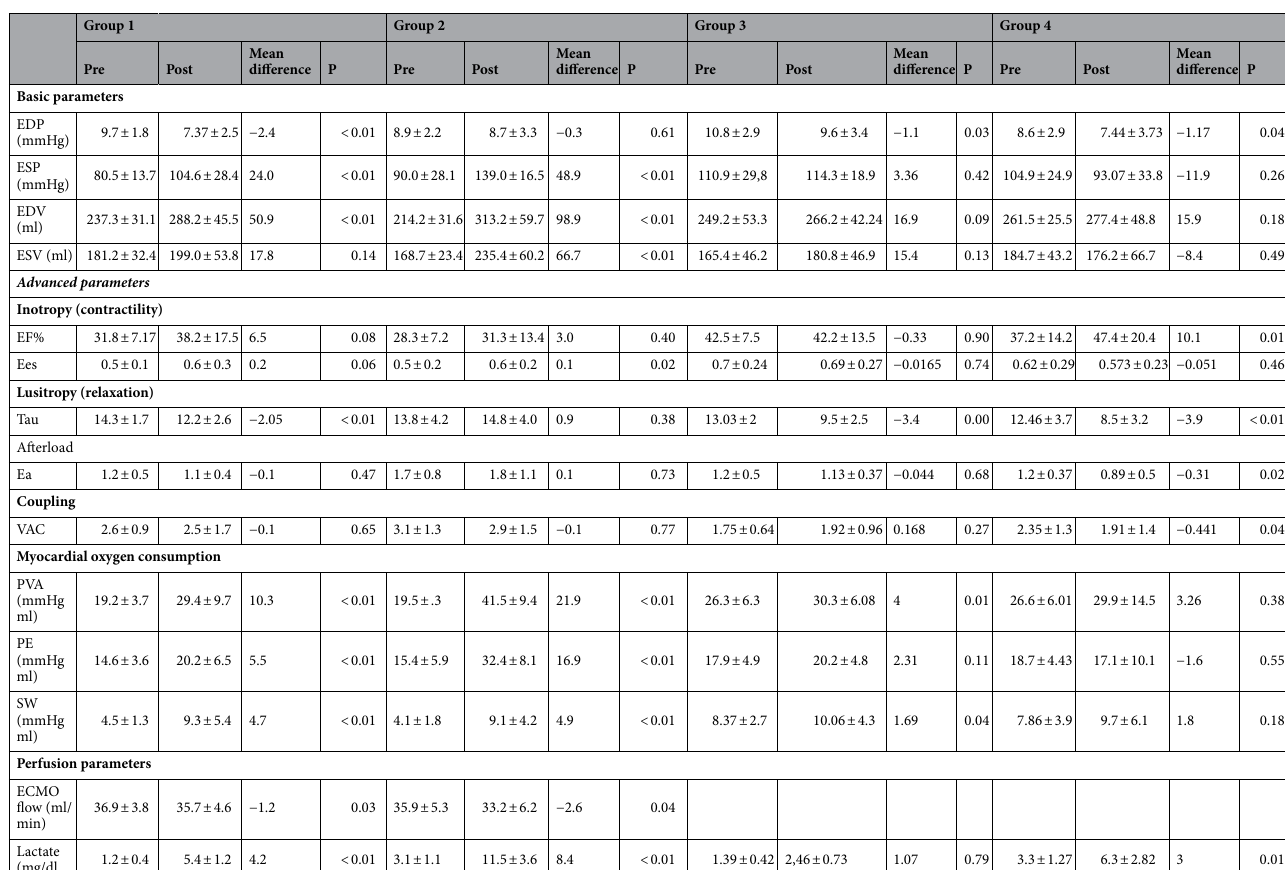
Table 2. Within group pre and post comparison of cardiovascular parameters. Ea arterial elastance, EDV end- diastolic volume, Ees end-systolic elastance, EF ejection fraction, ESV end-systolic volume, PE potentialenergy, PVA pressure–volume area, SW stroke work.